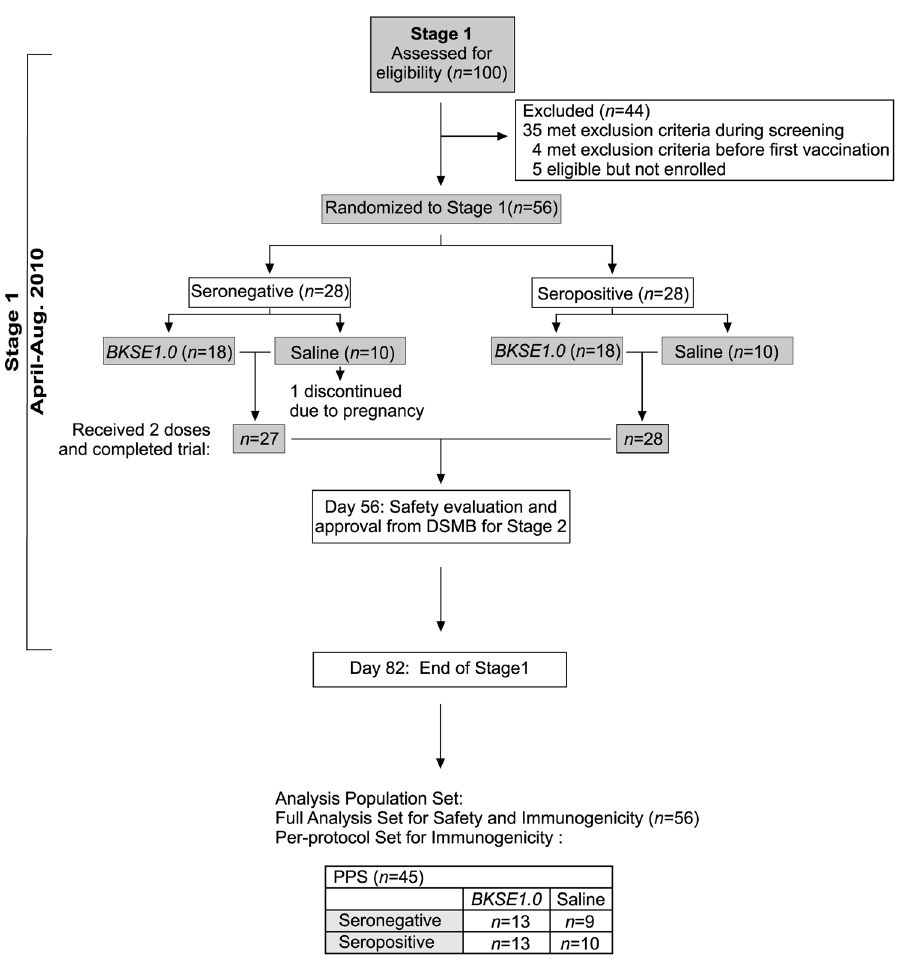
Figure 1. Enrollment and outcomes for Stage1. The number of subjects screened, those excluded (due to various medical conditions), those randomized to each treatment, events leading to changes in subject number and the final number of subjects contributing to analyses are indicated. All subjects were included in the full analysis set. Subjects with protocol deviations were excluded from the immunogenicity per-protocol set. Exclusive use of the whole third floor at LMC, facilitated transport and LMC being a primary health provider in Lira and neighboring districts favored high subject compliance rates to clinic visits.